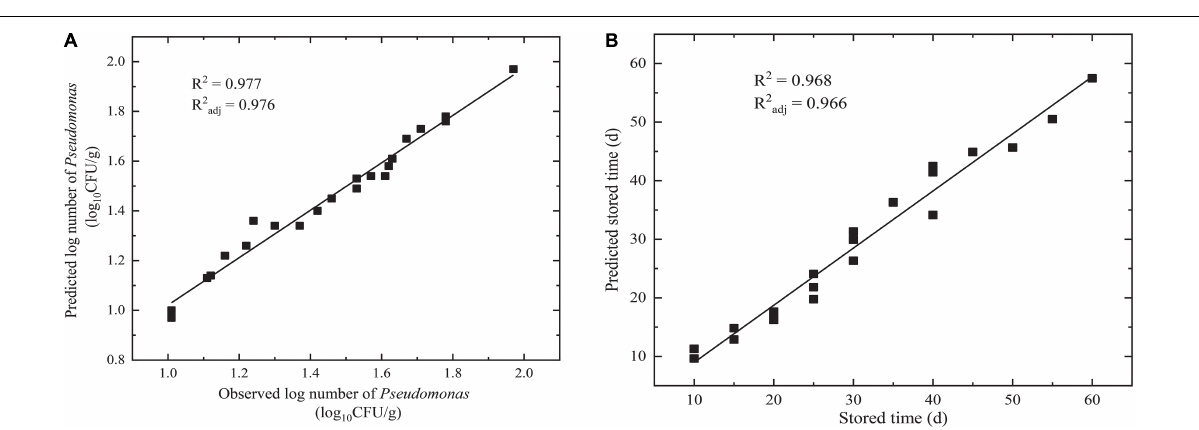
FIGURE 4 | Linear fit for observed and predicted numbers based on DAM for NGB from external data. (A) Observed and predicted numbers of Pseudomonas ; (B) observed and predicted storage times. TABLE 1 | Validation parameters for DAM describing the growth of microorganisms or storage time for NGB. Sample Equation Data MRE /% RMSE %SEP A f B f NGB Equation 15 (predicted log N T ) Internal 0.60 External 1.60 Equation 16 (predicted storage time)